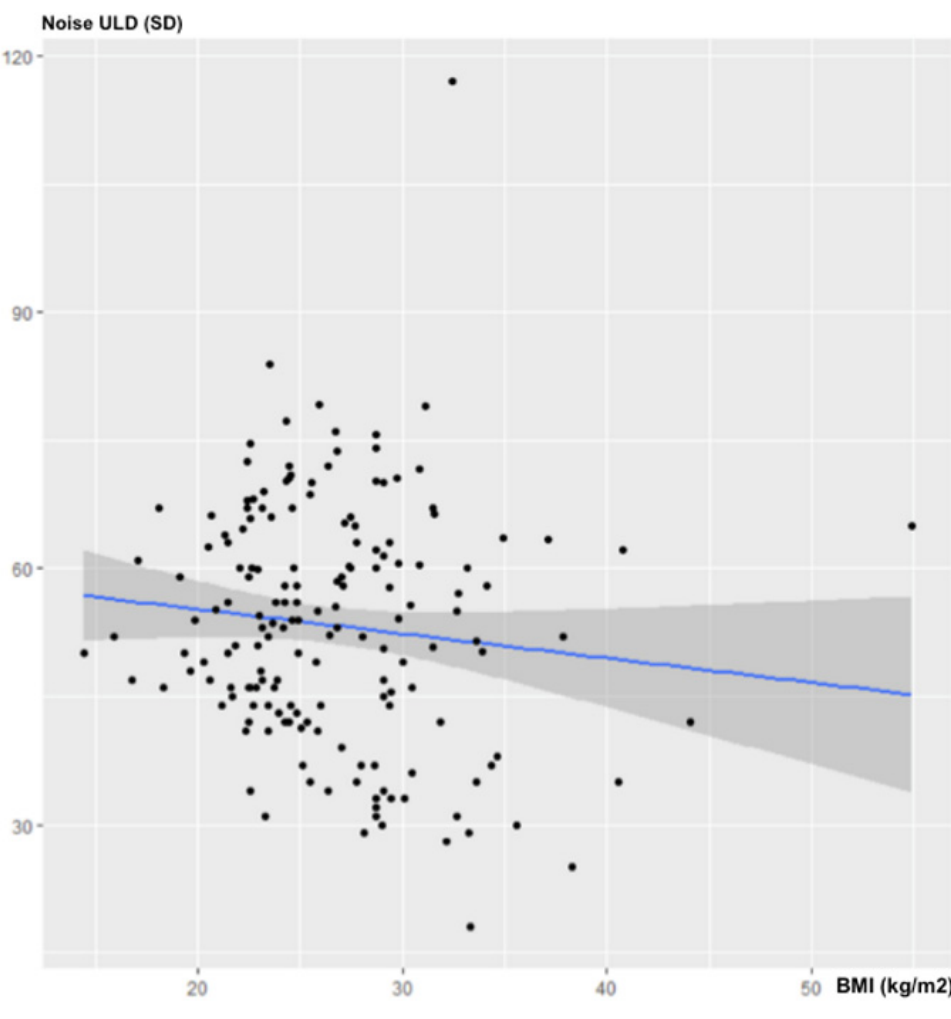
Figure 1. Influence of BMI on noise for ULD-CT.